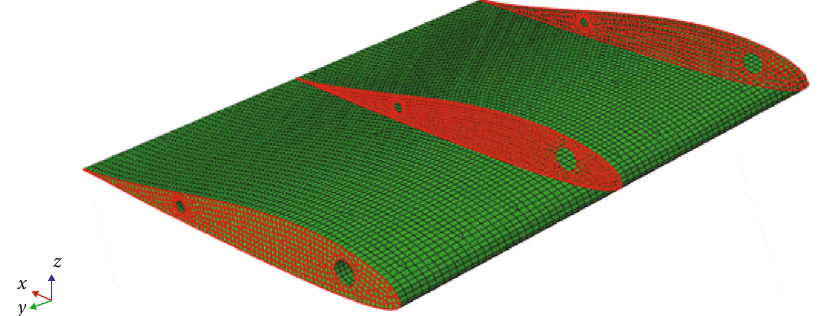
Figure 14: Finite element model of wing